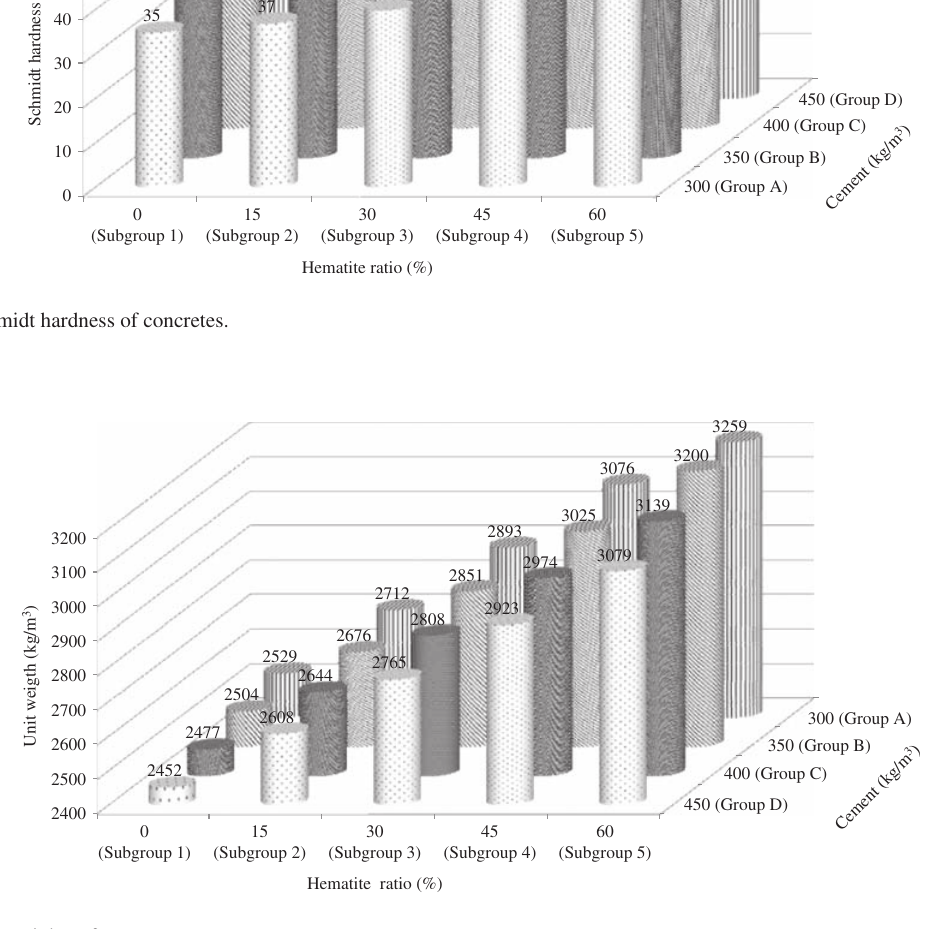
Figure 9 Unit weights of